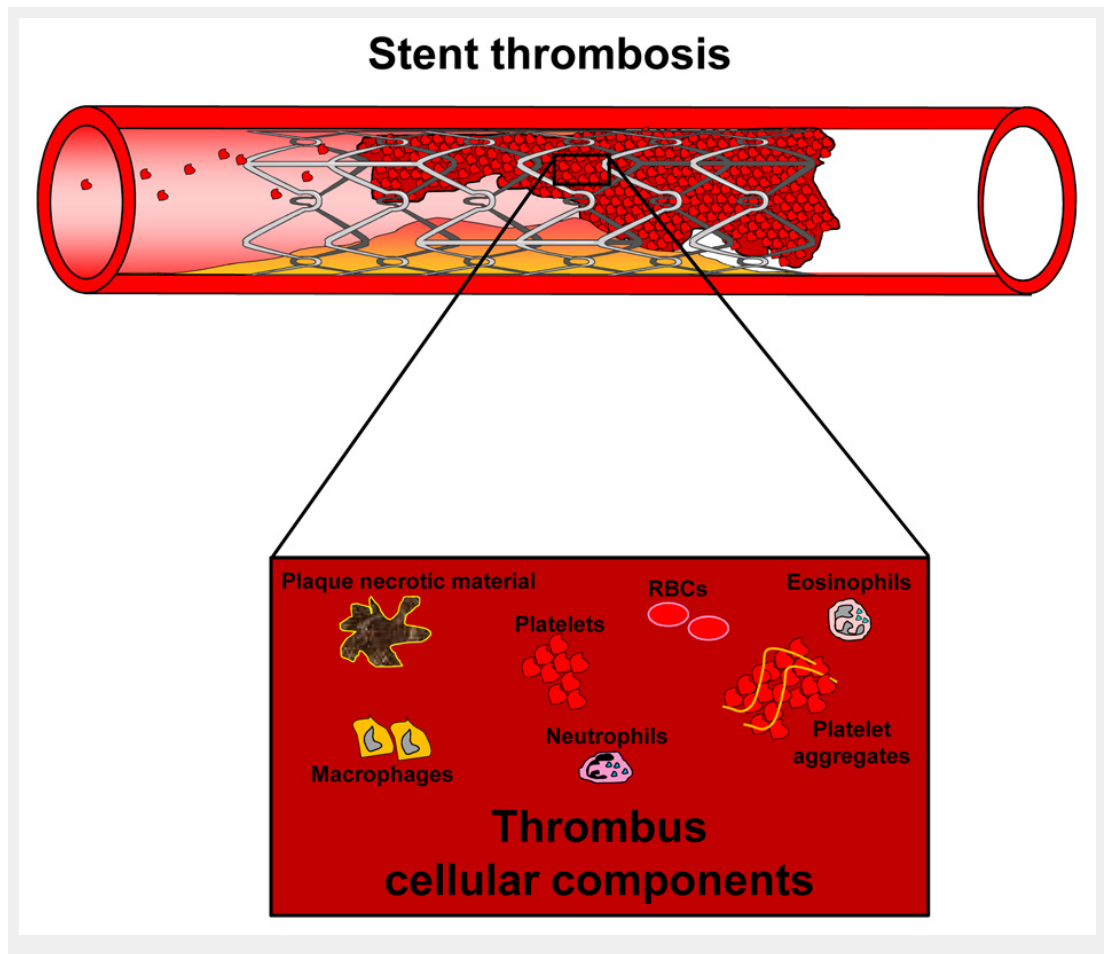
Figure 1 In-stent thrombosis: stent thrombosis is a rare but serious complication, often resulting in acute ischaemic events in downstream tissues and patient death. It is caused by atherothrombotic processes within the lumen of the stent with the subsequent acute occlusion of the vessel. The thrombus is a heterogeneous tissue, which includes platelets, platelet aggregates, inflammatory cells (eosinophils, neutrophils, macrophages), entrapped red blood cells (RBC) and necrotic parts of the ruptured atherosclerotic